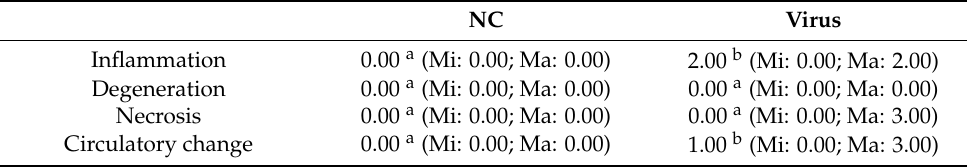
Table 3. Histopathological analysis of liver from CE infected with Gammacoronavirus .